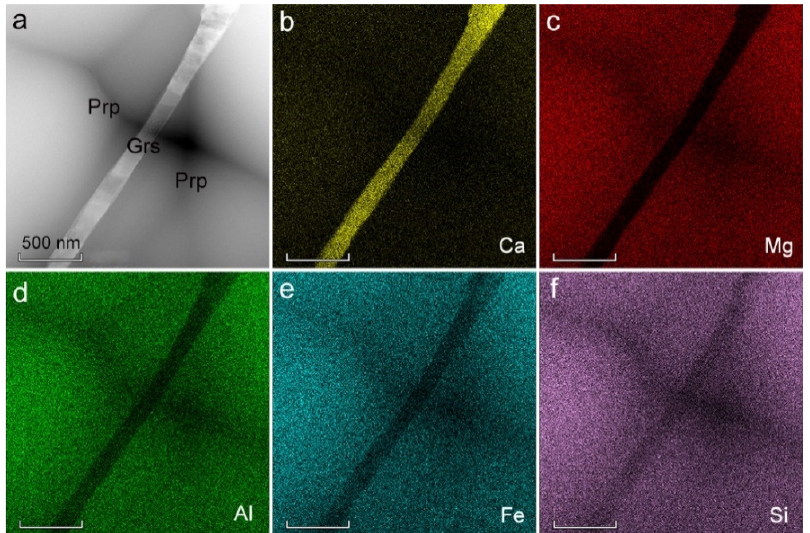
Figure 7. EDS-maps of major elements in grossular exsolutions and pyrope host. ( a ) Bright field image of grossular lamellae precipitated at the subgrain boundary of host pyrope. ( b – f ) Major elements distribution maps of the area in ( a ).